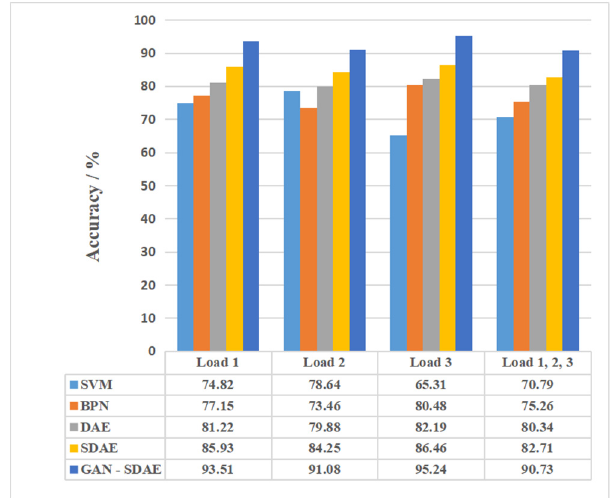
Figure 17. Accuracy of different fault diagnosis methods.